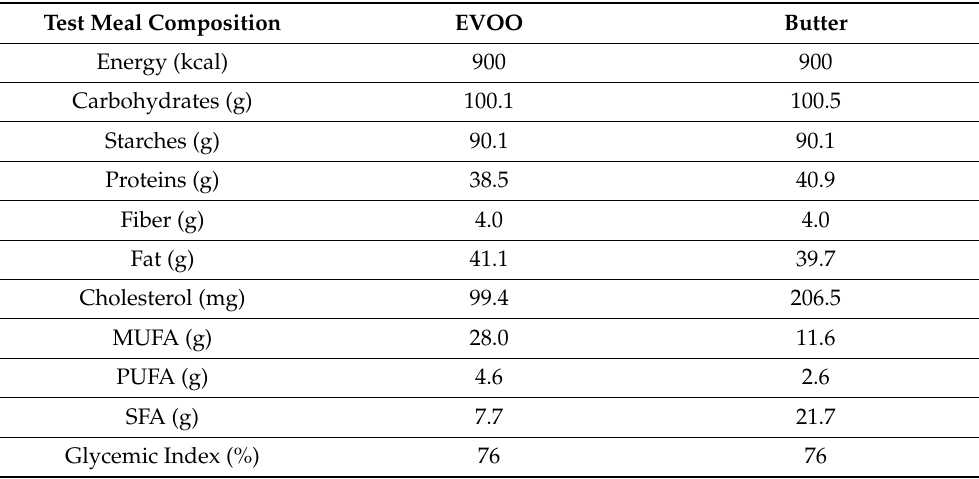
Table 1. Energy content and macronutrient composition of the test